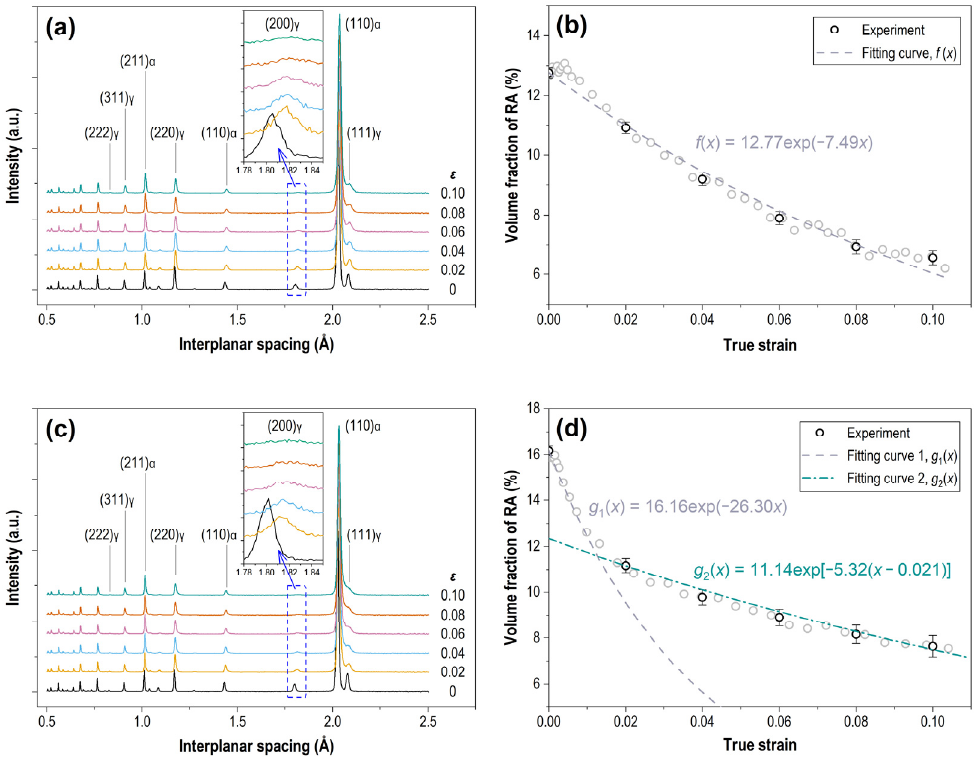
Figure 2. Variations in the RA volume fraction with deformation. ( a , c ) Neutron diffraction patterns of QP1.7Si and QP2.5Si at specific strains during the in situ loading. ( b , d ) Volume fraction of RA as a function of the true strain in QP1.7Si and QP2.5Si.